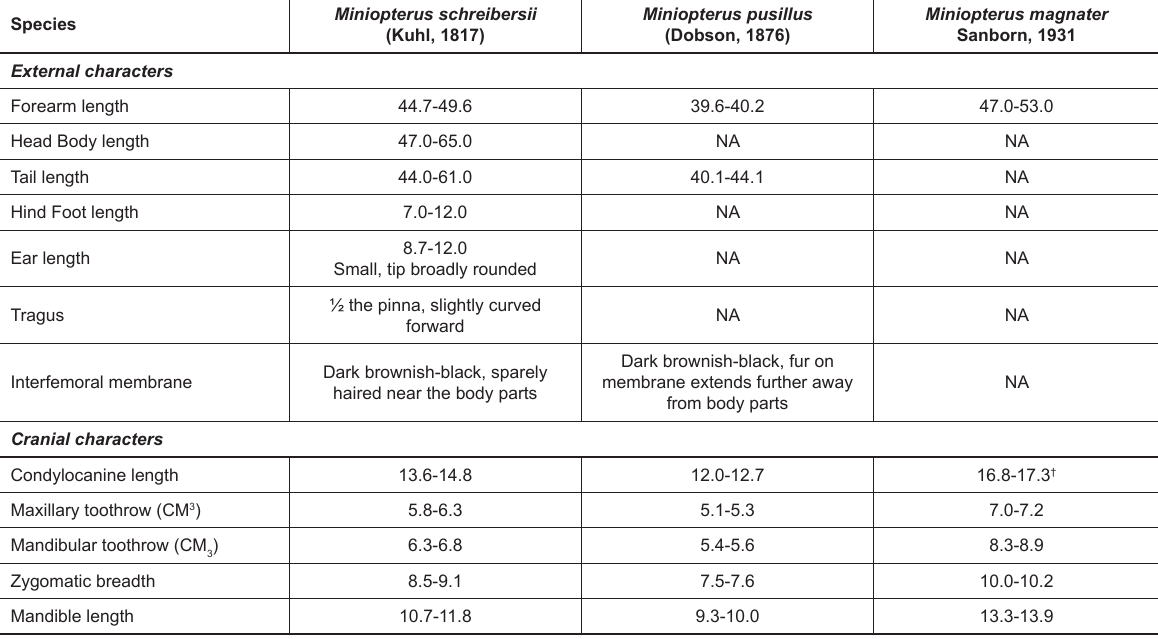
Table 8.1. Diagnostic morphological characters of species of the genera Miniopterus Bonaparte, 1837 present in South